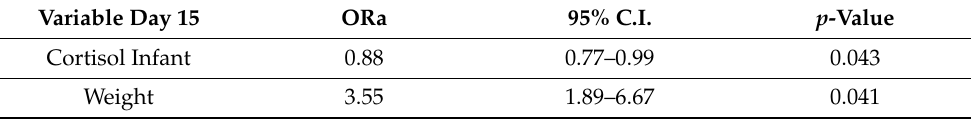
Table 4. Binary logistic regression analysis of kangaroo mother method